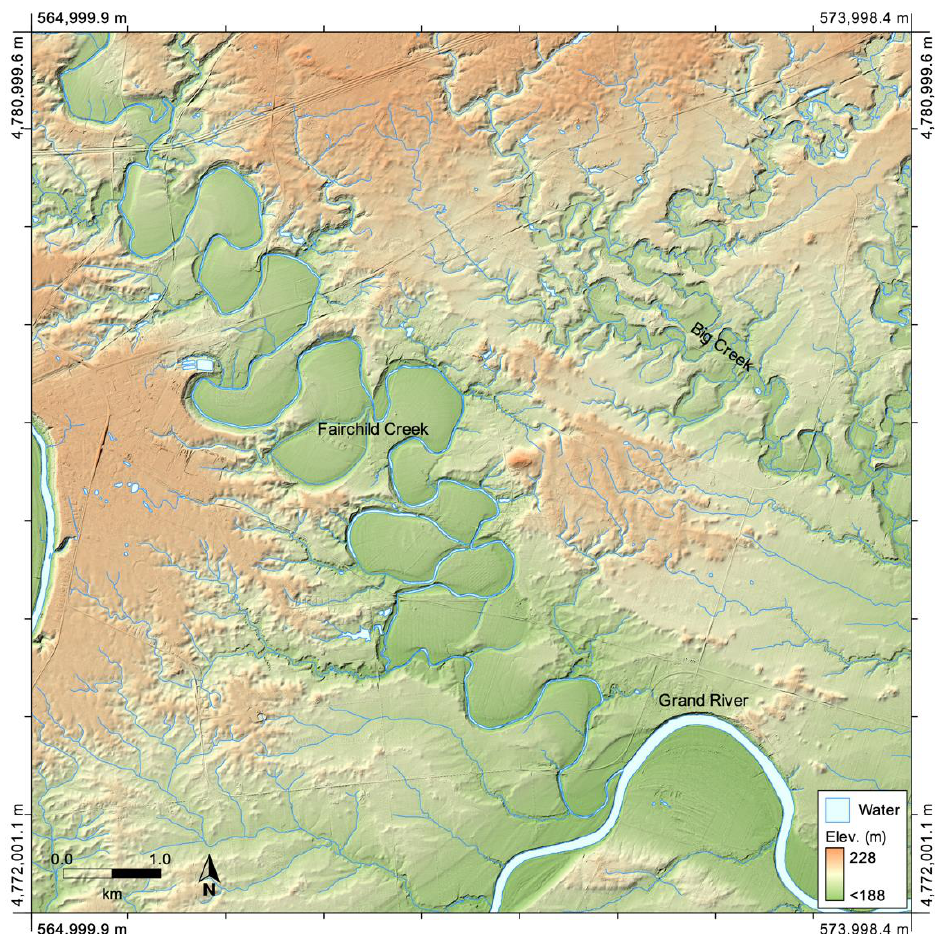
Figure 2. The study site located northeast of Brantford, within Southwestern Ontario, Canada. The 0.5 m resolution DEM is displayed here with shaded relief to emphasize topographic variation.